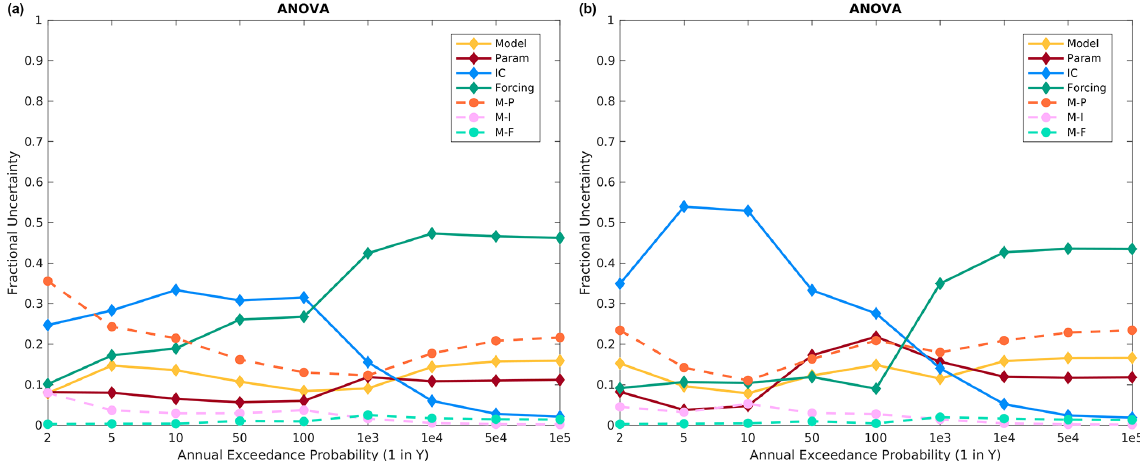
Figure 12. Altus fractional variance contributions using the three base models, namely HEC-HMS, VIC, and SAC-SMA, for the (a) specified meteorological sequence and (b) historical meteorological sequence.